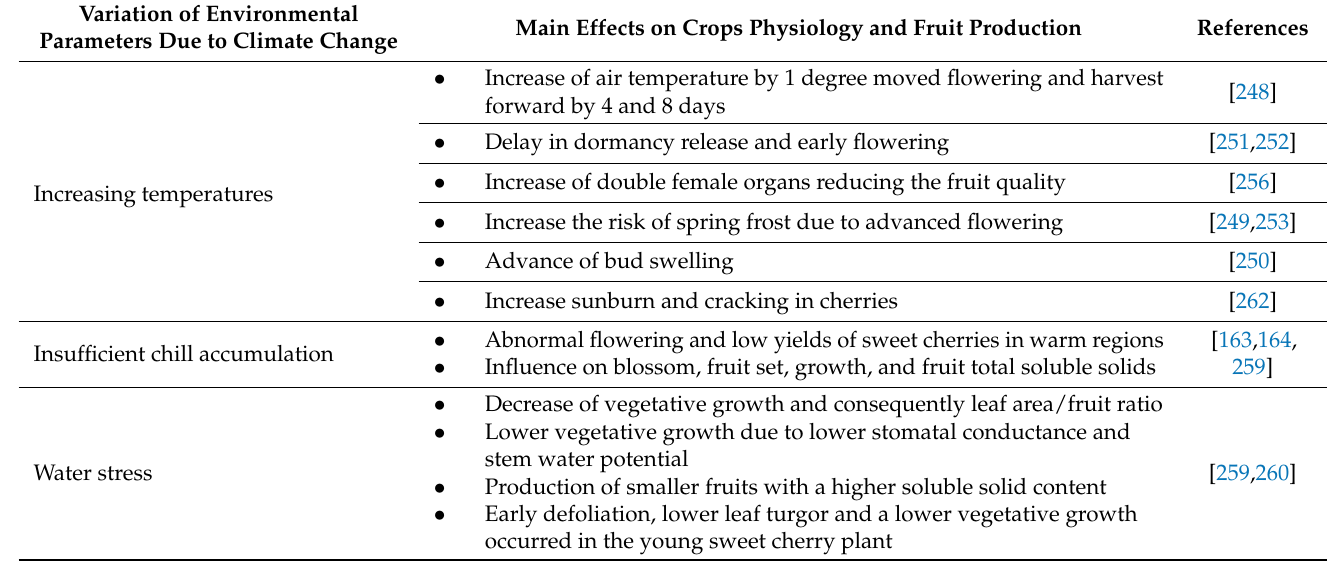
Table 9. Summary of principal effects of environmental conditions variation on cherry species.